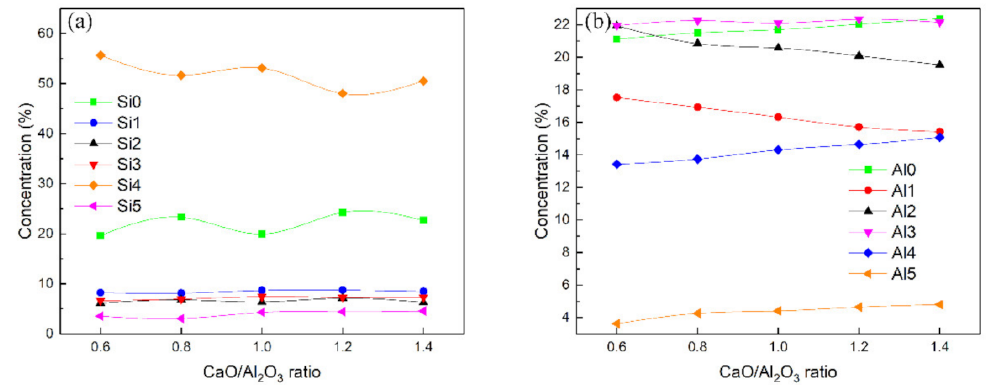
Figure 8. Variation of Q n with different CaO/Al 2 O 3 ratios: ( a ) Q n of Si, and ( b ) Q n of